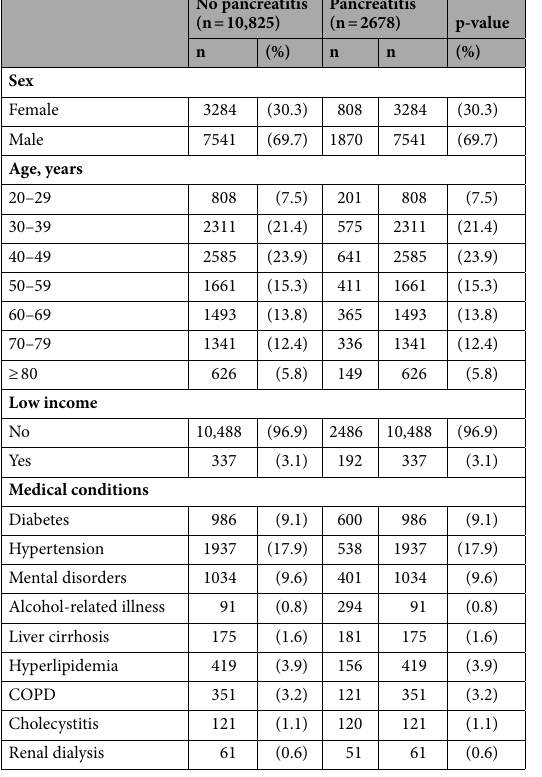
Table 1. Baseline characteristics of people with and without pancreatitis. COPD chronic obstructive pulmonary